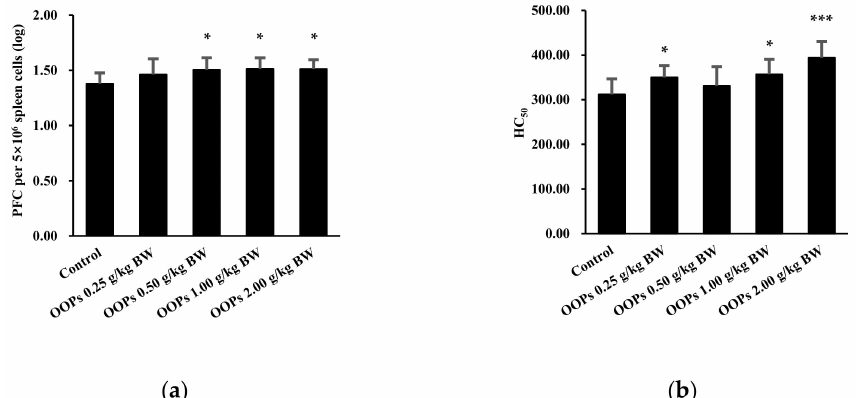
Figure 1. E ff ects of OOPs on humoral immunity in mice. ( a ) Spleen immunoglobulin (Ig) M antibody response to sheep red blood cells (SRBC); ( b ) Serum half hemolysis value (HC 50 ). Data was represented as mean ± SD, n = 10. * p < 0.05 vs. control group, *** p < 0.001 vs. control group.